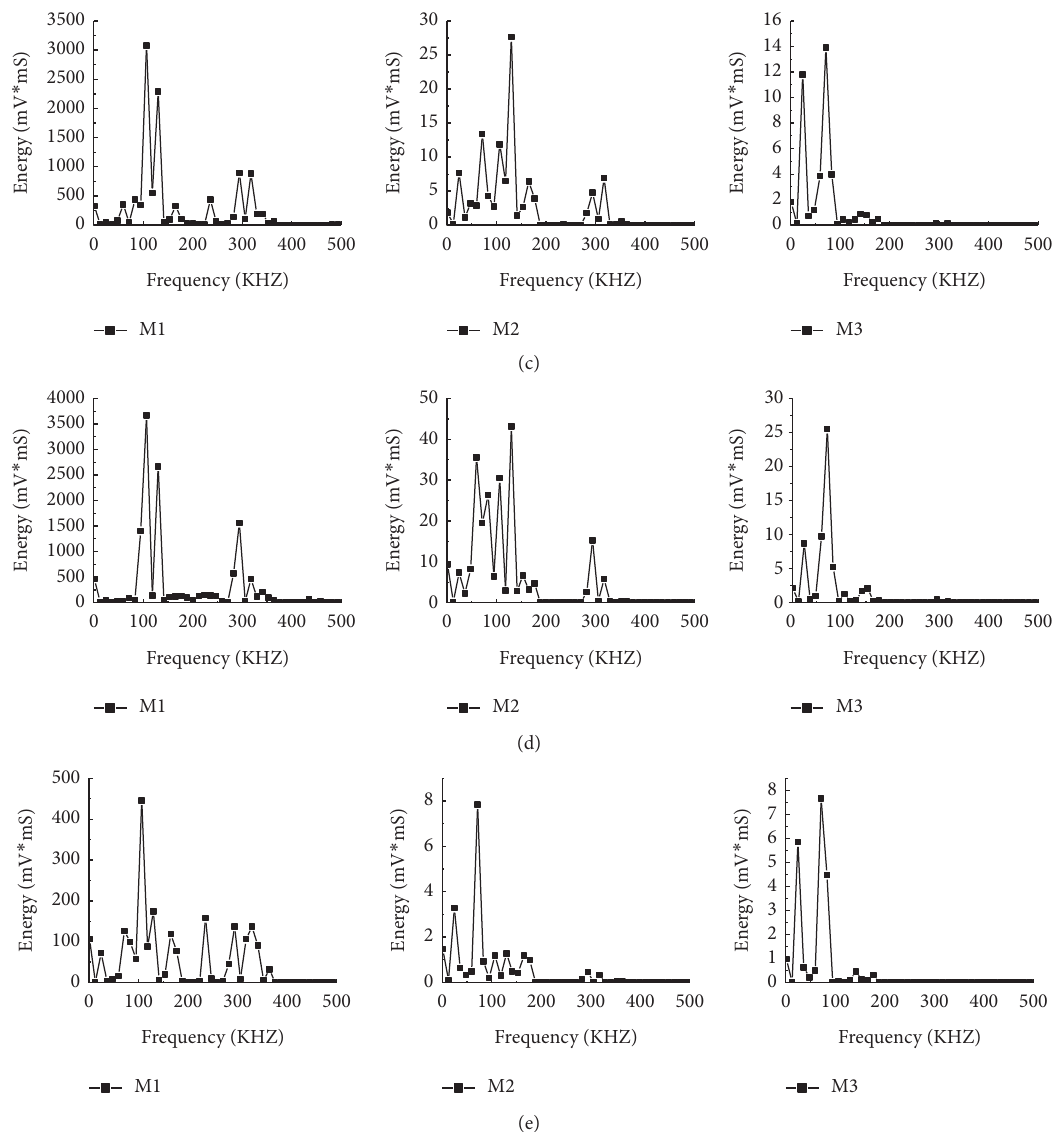
Figure 11: The energy distribution of acoustic emission signal frequency band of rod-shaped rock. (a) G3768. (b) G3561. (c) TBG. (d) AAM. (e)